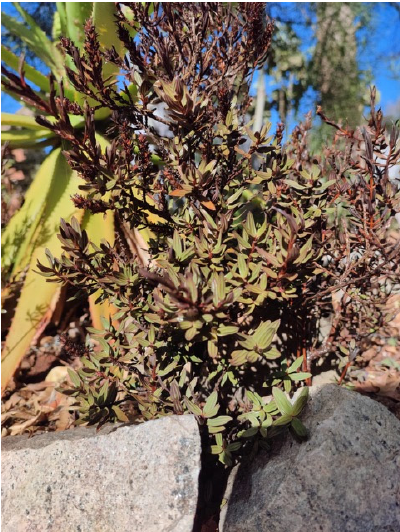
Figure 1. Myrtothamnus moschatus during the rainy season.